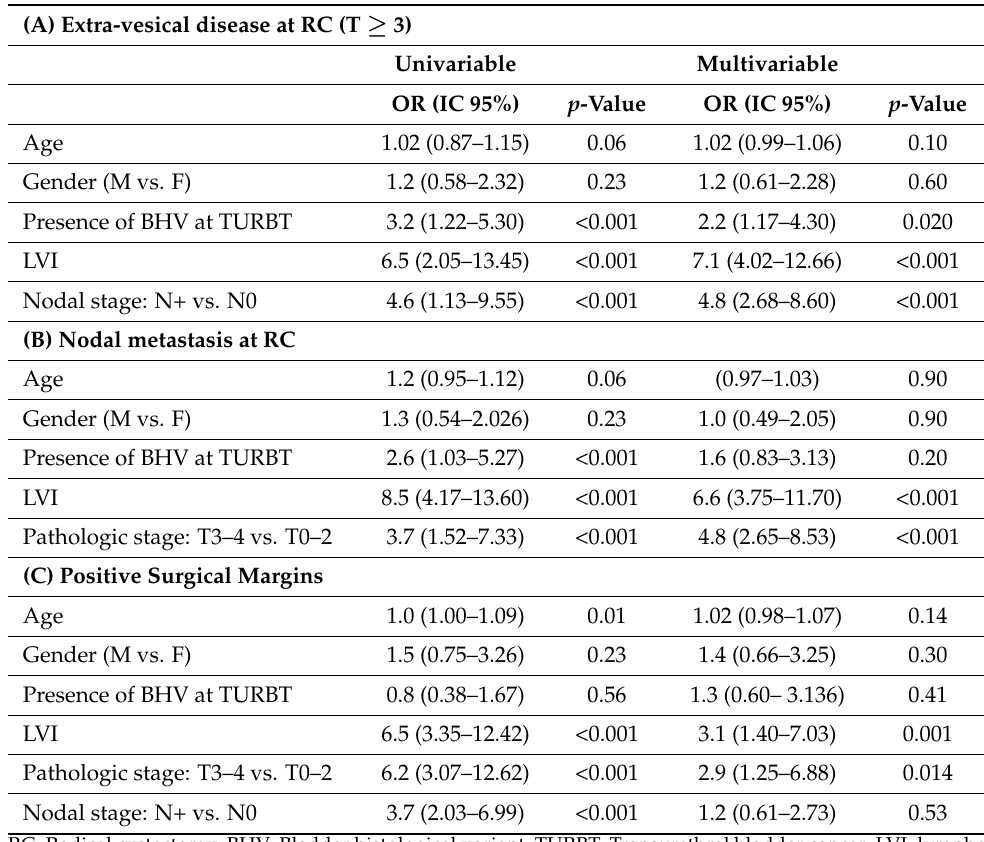
Table 3. Univariable and Multivariable logistic regression predicting extra-vesical disease (T ≥ 3) ( A ), nodal metastasis at RC ( B ) and positive surgical margins ( C